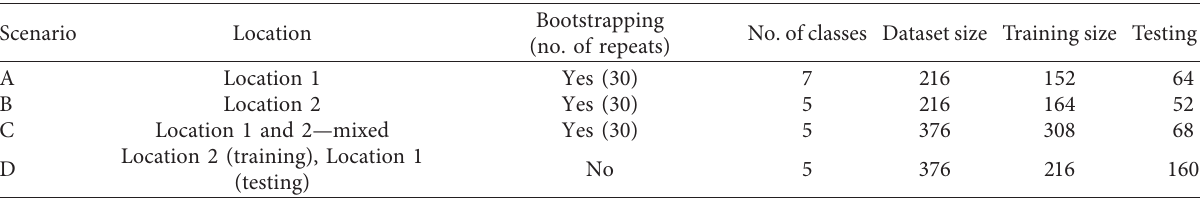
Figure 4: Effect of signal resampling to a different number of samples. (a) Original signal with 5791 samples. (b) Resampled to 100 samples. (c) Resampled to 200 samples. (d) Resampled to 500 samples. (e) Resampled to 1000 samples. (f) Resampled to 2000 samples. Table 5: Setup of evaluated use case scenarios.